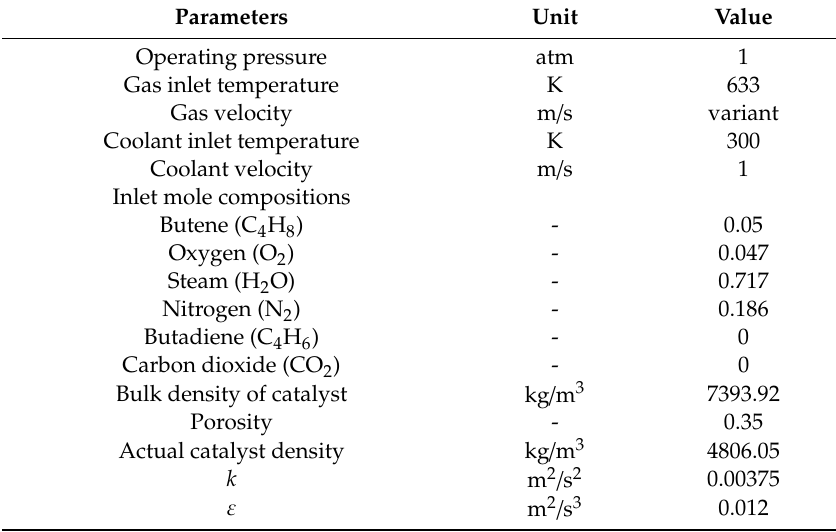
Table 3. Process conditions and model